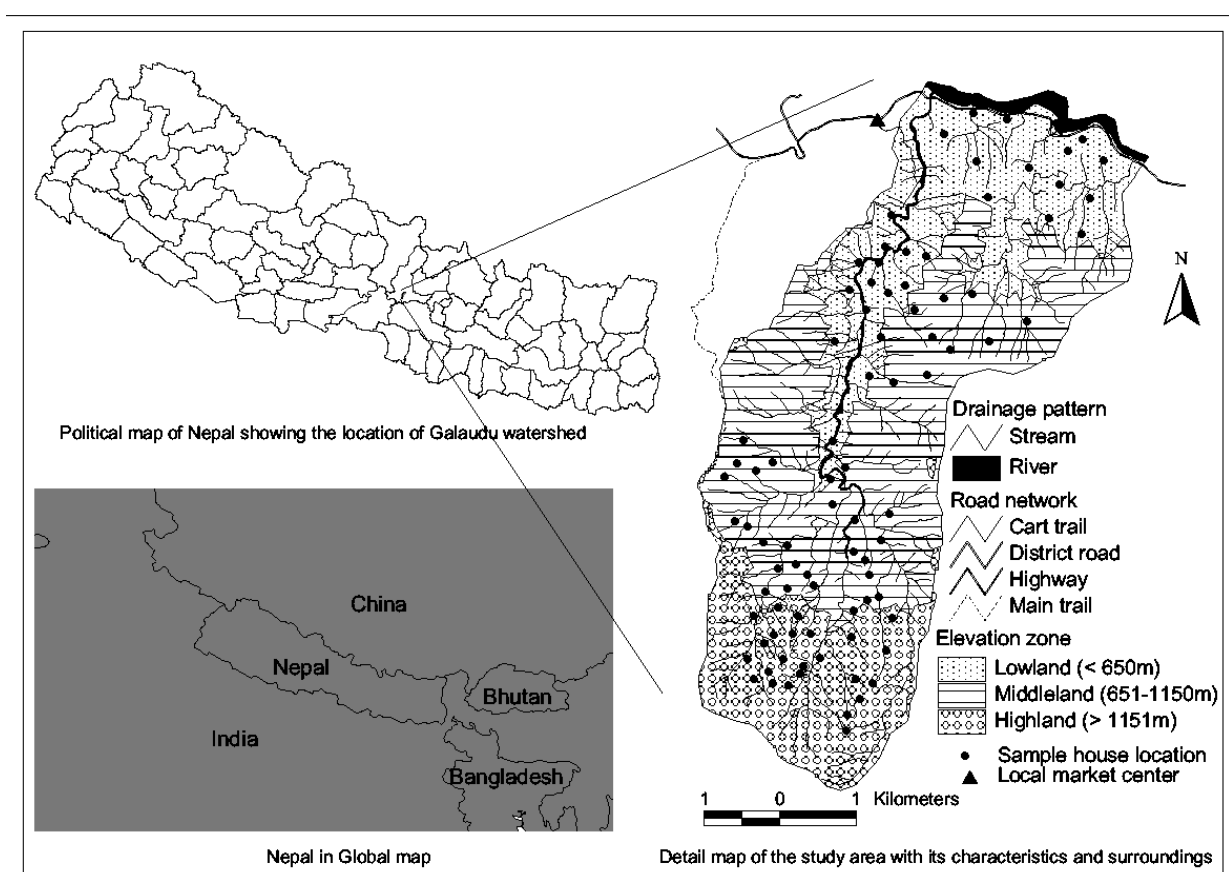
Figure 1. Location of the study